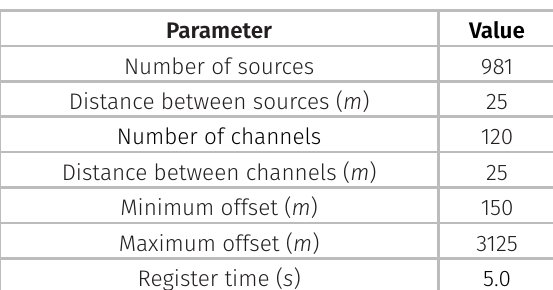
Table I. Acquisition geometry of seismic line 0214-0270 in the Jequitinhonha